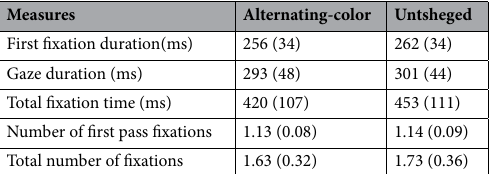
Table 5. Means (and standard deviations) of eye movement measures based on global